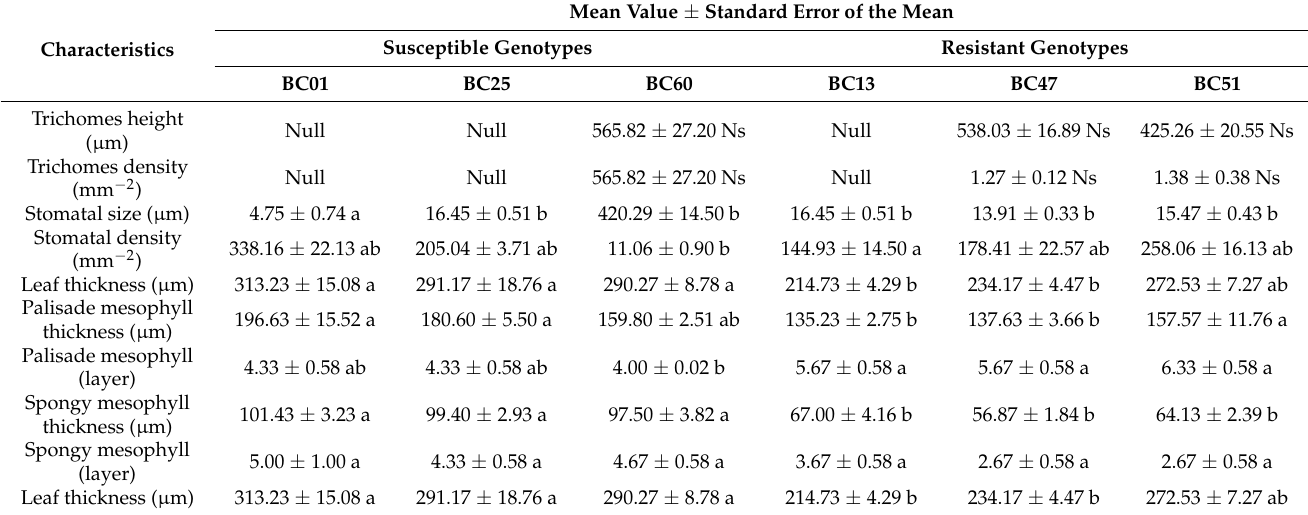
Table 2. Characteristics and parameters of the lower leaf epidermis and leaf structure of susceptible and resistant accessions.